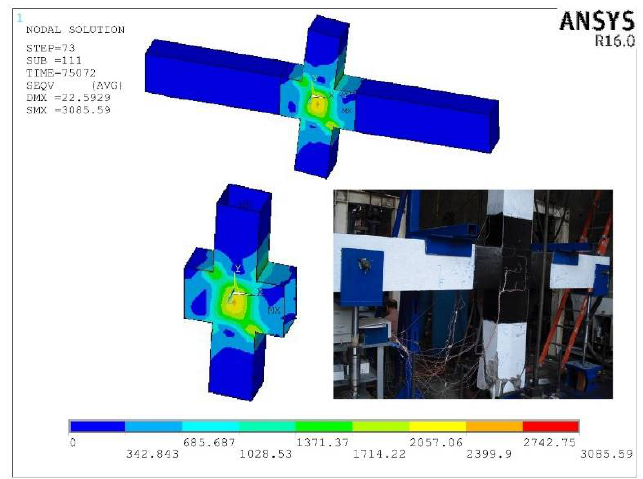
Figure 6. Stress contours validation.